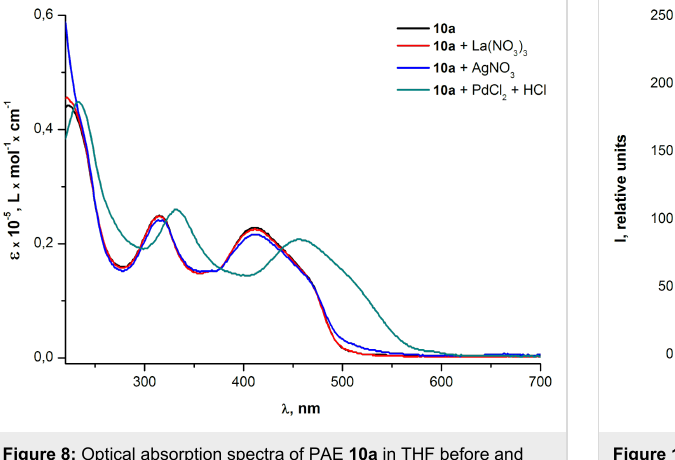
Figure 10: Emission spectra of PAE 10a in THF before and after the addition of metal ions.